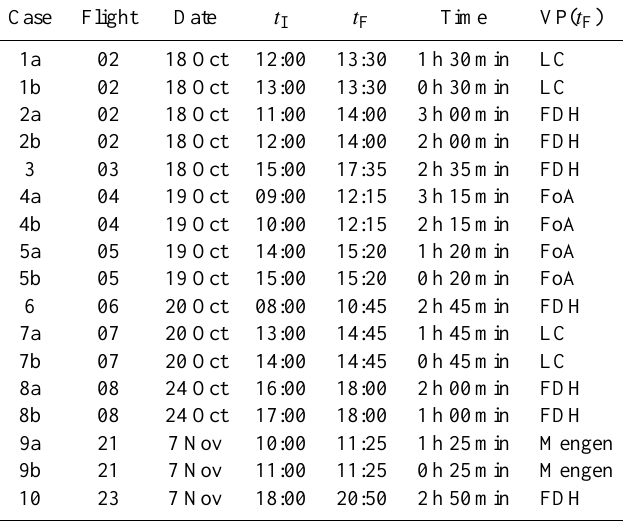
Table 1. List of all singular vector simulations included in the ZEPTER-2 case study. Initial time ( t I ) and final time ( t F ) of simulation are given in UTC; the length of the simulation (time) is given in hours and minutes. VP (t F ) denotes the location of the vertical measurement profile at final time, FDH designates Friedrichshafen airport, LC Lake Constance, FoA Forest of Altdorf, and Mengen denotes the city of